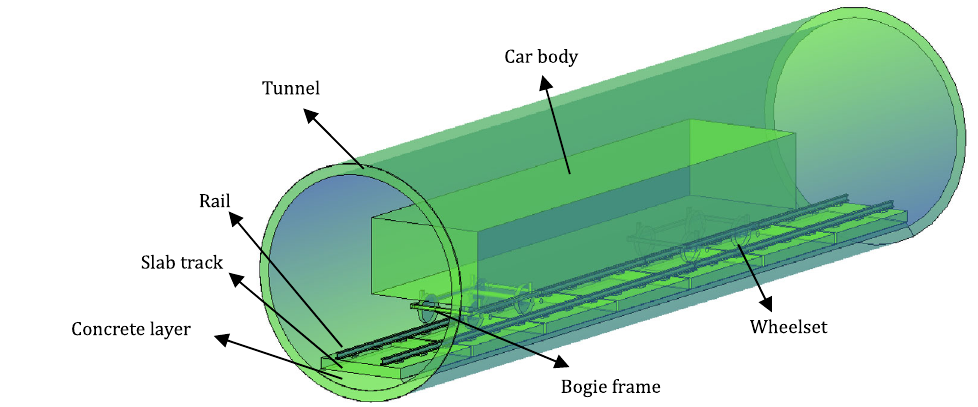
two bogie frames and four wheelsets. Each body considers five DOFs including the lateral displacement, the vertical displacement, the yaw angle, the roll angle and the pitch angle. The track structures are modelled as a ballastless track including the rail (Euler–Bernoulli beams), the slab track (thin plates), the rail pads (spring-dashpot elements) and the concrete layer (spring-dashpot elements) support- ing the track. The tunnel is assembled by tunnel rings, and each ring consists of several tunnel segments. The tunnel rings and segments are connected by joints.